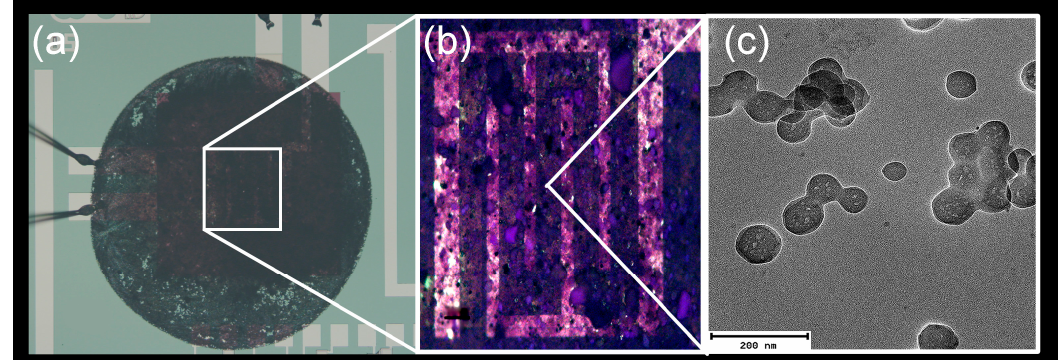
Figure 3. ( a ) Image of resulting deposition of ZIF nanocrystals solution by drop coating; ( b ) layer of ZIF deposited on microfabricated electrodes; ( c ) TEM image of ZIF-8 nanocrystal.